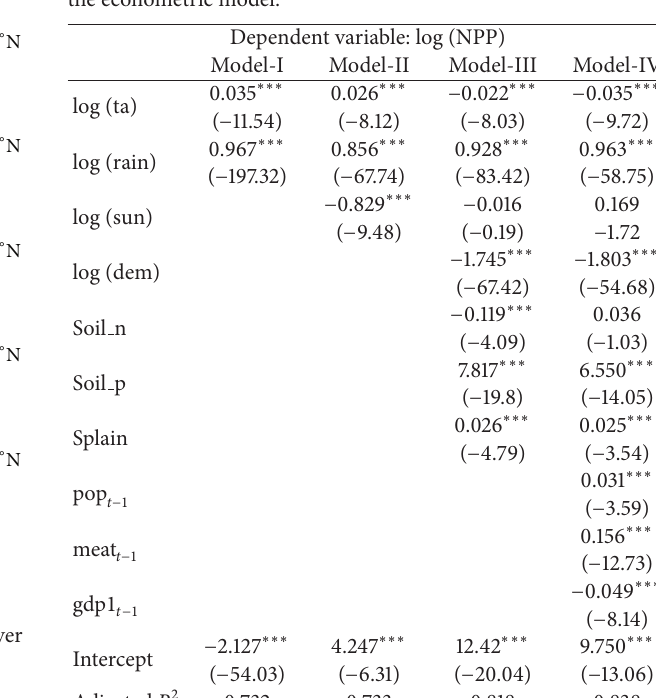
Table 2: Analysis of impacts of influencing factors on NPP based on the econometric